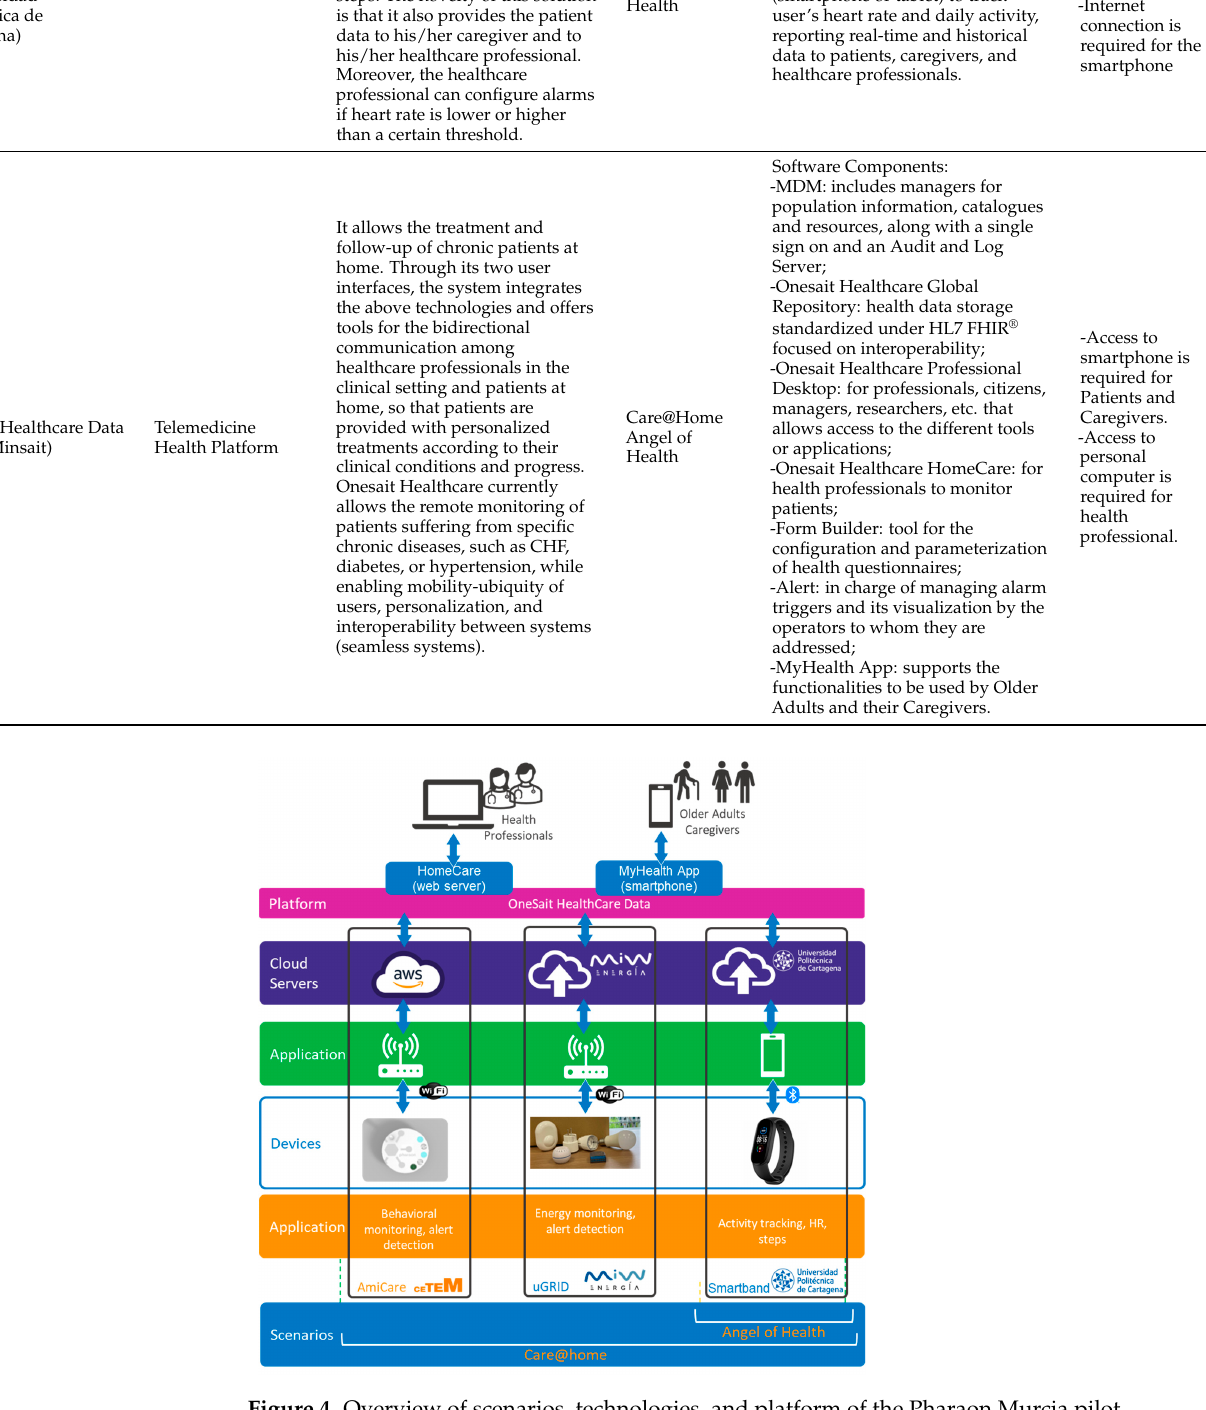
Figure 4. Overview of scenarios, technologies, and platform of the Pharaon Murcia pilot.